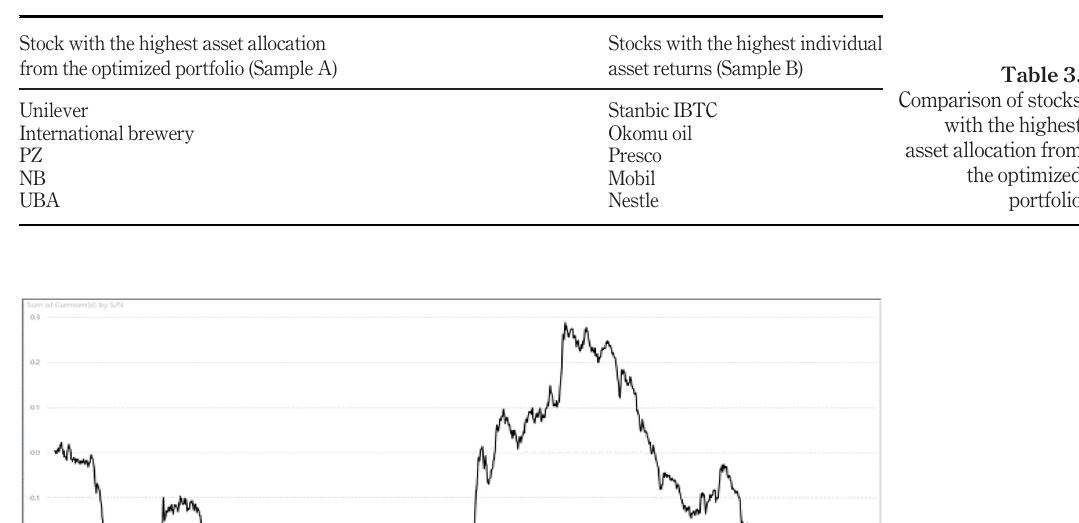
Figure 2. Optimalinvestment returns, https://bit.ly/